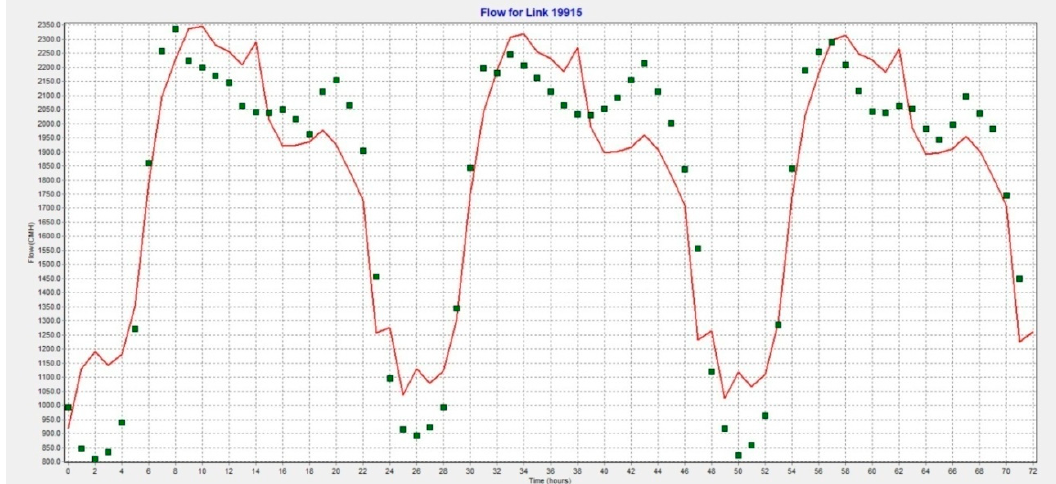
Figure 9. Results of Scenario I for Tanks E, west direction.